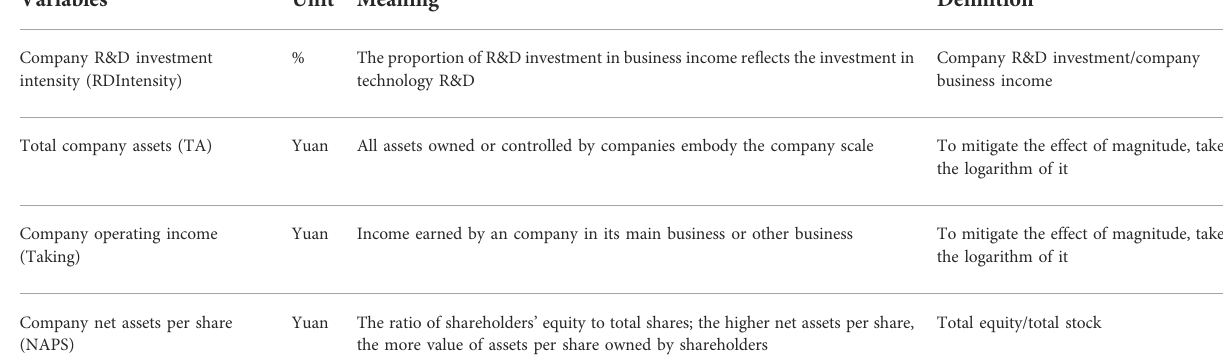
TABLE 4 PSM control